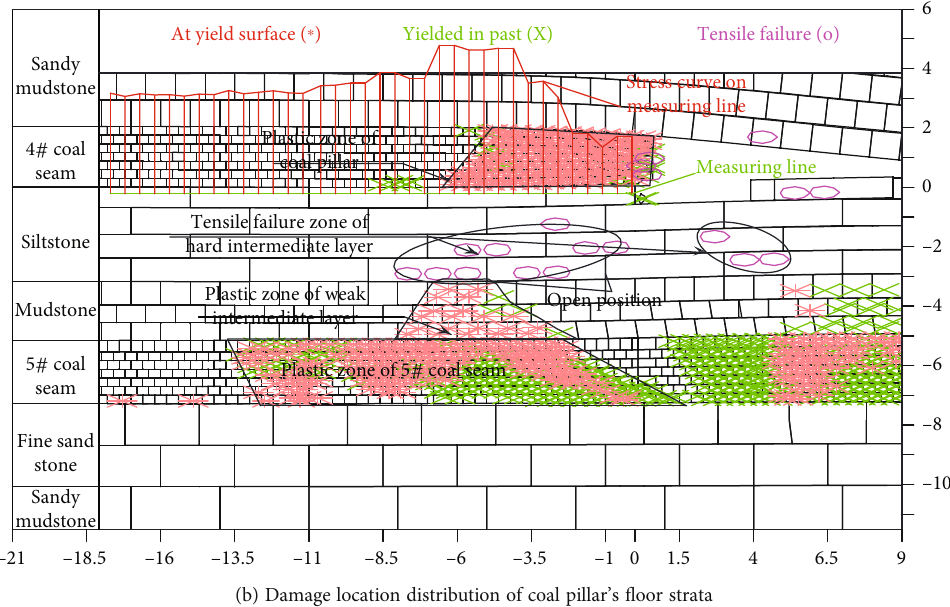
Figure 4: Stress distribution and damage location of strata under coal